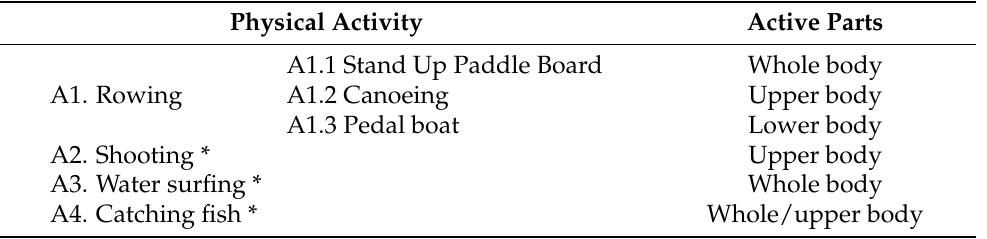
Table 2. Physical activities in VRrowing .